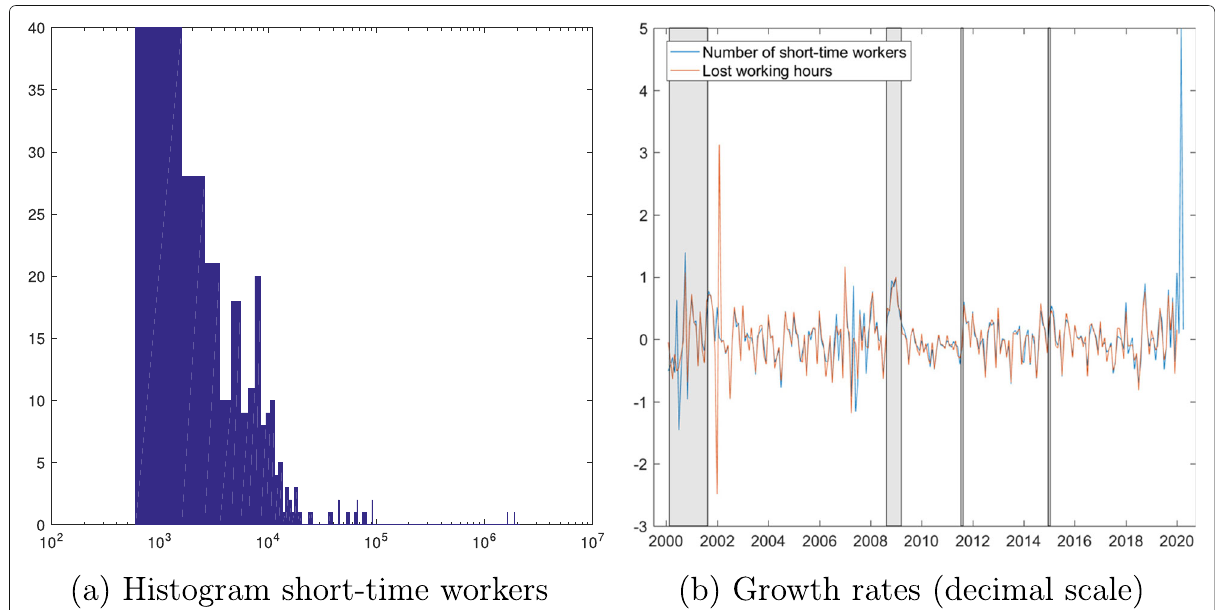
Fig. 2 Short-time workers and lost working hours. Monthly frequency. Gray bars highlight the dotcom and financial crises, the introduction, and discontinuation of the euro-Swiss franc floor. Series merged from the three data sources (see footnote to Figure 1), the observation for short-time workers in January 2020 is taken from the e-mail source